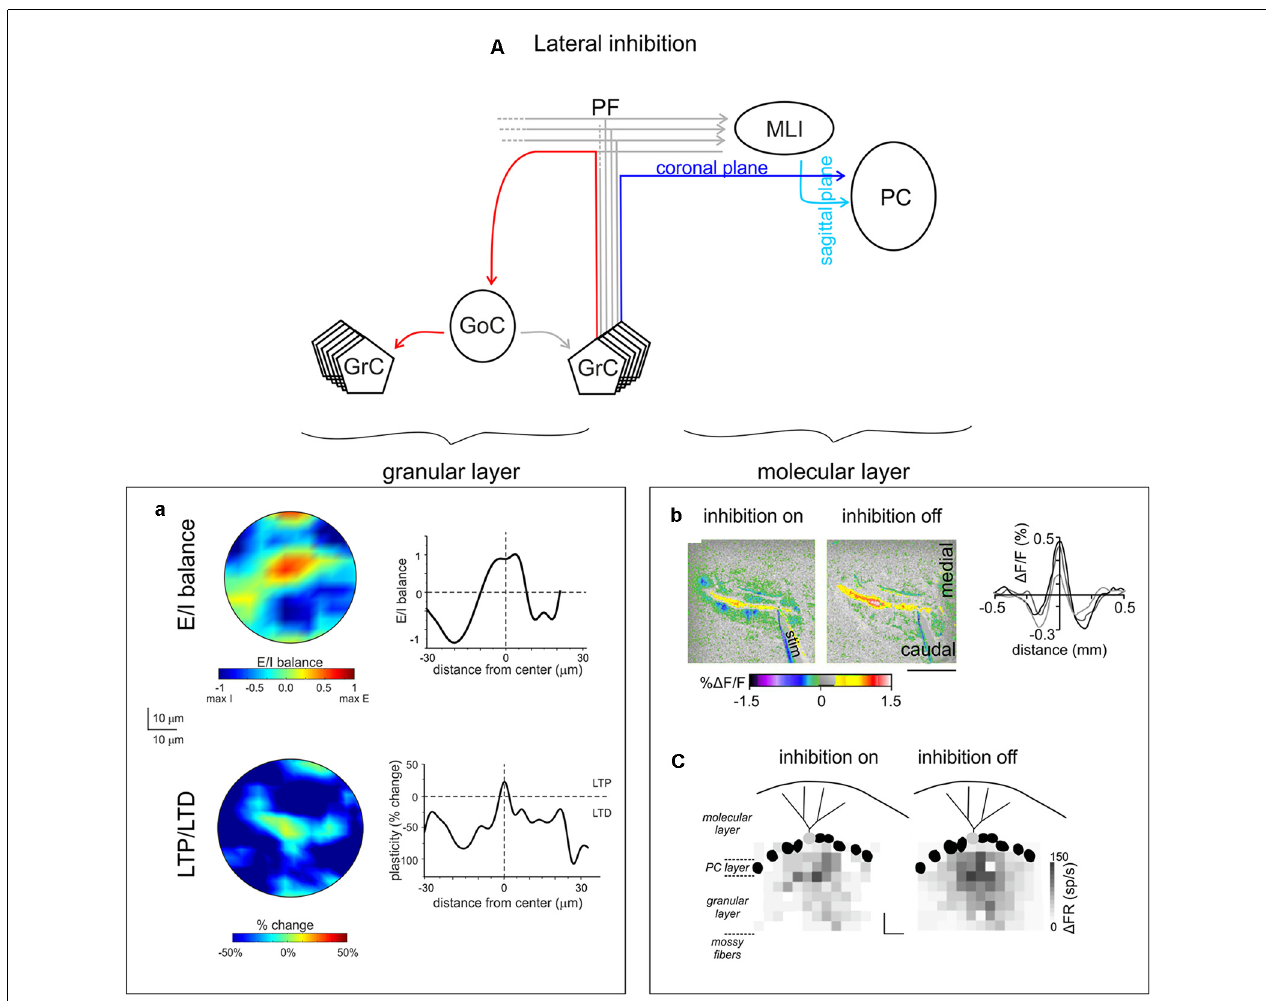
FIGURE 6 | Lateral inhibition in the cerebellar cortex. (A) Schematic of the cerebellar circuit of lateral inhibition, with the relevant granular and ML connectivity highlighted at left and at right, respectively. (a) GoCs generate a broad lateral inhibition that extends beyond the afferent synaptic field. The center-surround effect is generated by lateral inhibition. After excitation, GrCs in the core are more activated than those in the surrounding area. Below, long-term synaptic plasticity is controlled by Golgi cell synaptic inhibition at the MF-granule cell synapse. The result is LTP in the center and LTD in the surround, so that LTP and LTD assume a center-surround organization. Modified from Soda et al. (2019). (b) MLIs provide the substrate for lateral inhibition of PCs by virtue of the orthogonal arrangement of excitation and inhibition onto PCs: the PFs run coronally, whereas the axons of MLIs run sagittally. Surface stimulation of the cerebellar cortex evokes a large on-beam increase in fluorescence attributable to PF excitation of its postsynaptic targets (PCs and MLIs) and a narrow off-beam decrease in fluorescence due to postsynaptic inhibition generated by MLIs. Blocking inhibition using bicuculline application abolishes off-beam decrease in fluorescence and enhances the on-beam increase in fluorescence (scale bar 1 mm). Right, intensity profiles of the fluorescence change perpendicular to the beam. Adapted from Gao et al. (2006). (c) Response maps of a single PC (light gray) in terms of change in firing rate (gray scale) with inhibition on or off, while stimulating different regions in the GL. The probability that pure and net inhibitory responses are elicited by granule cells increased as a function of lateral distance from the PC (scale bars 80 µ m × 80 µ m). Adapted from Dizon and Khodakhah